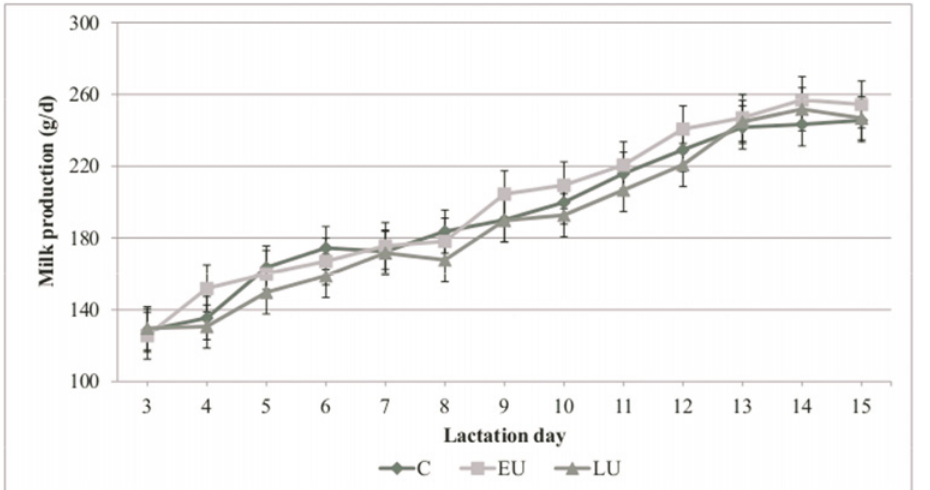
Fig 1. Effect of gestational undernutrition on milk production (g/d) of does at days 3 – 15 of lactation. C = does fed to 100% of maintenance energy requirements (n = 10); EU = does fed to 50% of maintenance energy requirements from day 7 to day19 of gestation (n = 8); LU = does fed to 50% of maintenance energy requirements from day 20 to day27 of gestation (n = 10). S.E. lines represent individual SEM.